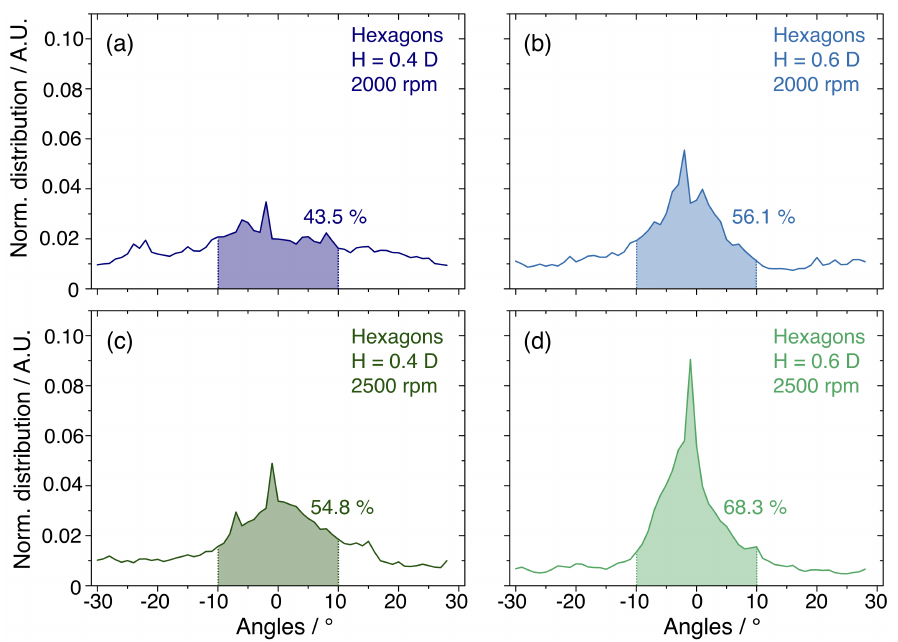
Figure 4. Line graphs reporting the normalised distribution of the domains orientation in the NSs monolayer confined in hexagonal graphoepitaxy structures with ( a ) H = 0.4 · D at 2000rpm, ( b ) H = 0.6 · D at 2000rpm, ( c ) H = 0.4 · D at 2500rpm and ( d ) H = 0.6 · D at 2500rpm. The orientation is evaluated in the angular range between − 30° and 30°. The percentage of domains aligned to the templates edges is calculated through the integral of the curve in the range from − 10° to 10° and the area and percent value are reported for each curve.